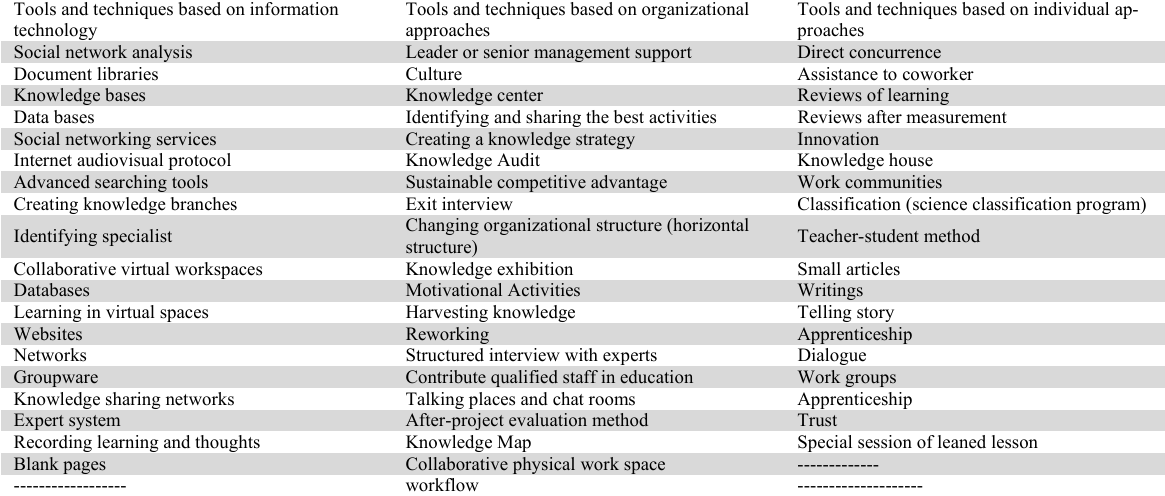
KM tools and techniques (Ghomi, 2014) Tools and techniques based on information technology